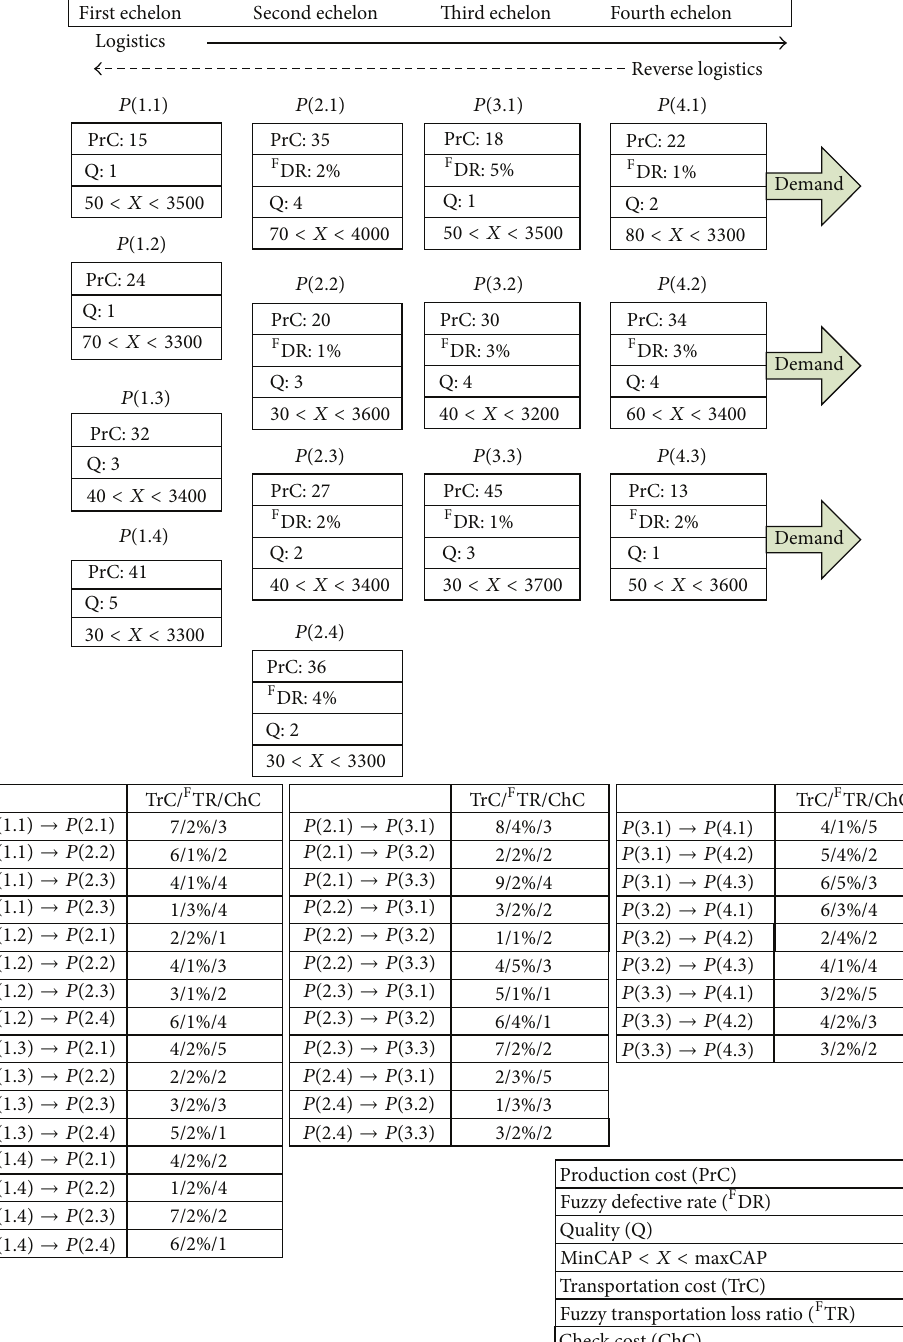
parameters is: particle number 10, generation number 1000, maximum speed 1.25, inertia weight 2.15, learning factor 2.05, start temperature 400, Markov Chain 100, cooling rate 0.99, end temperature